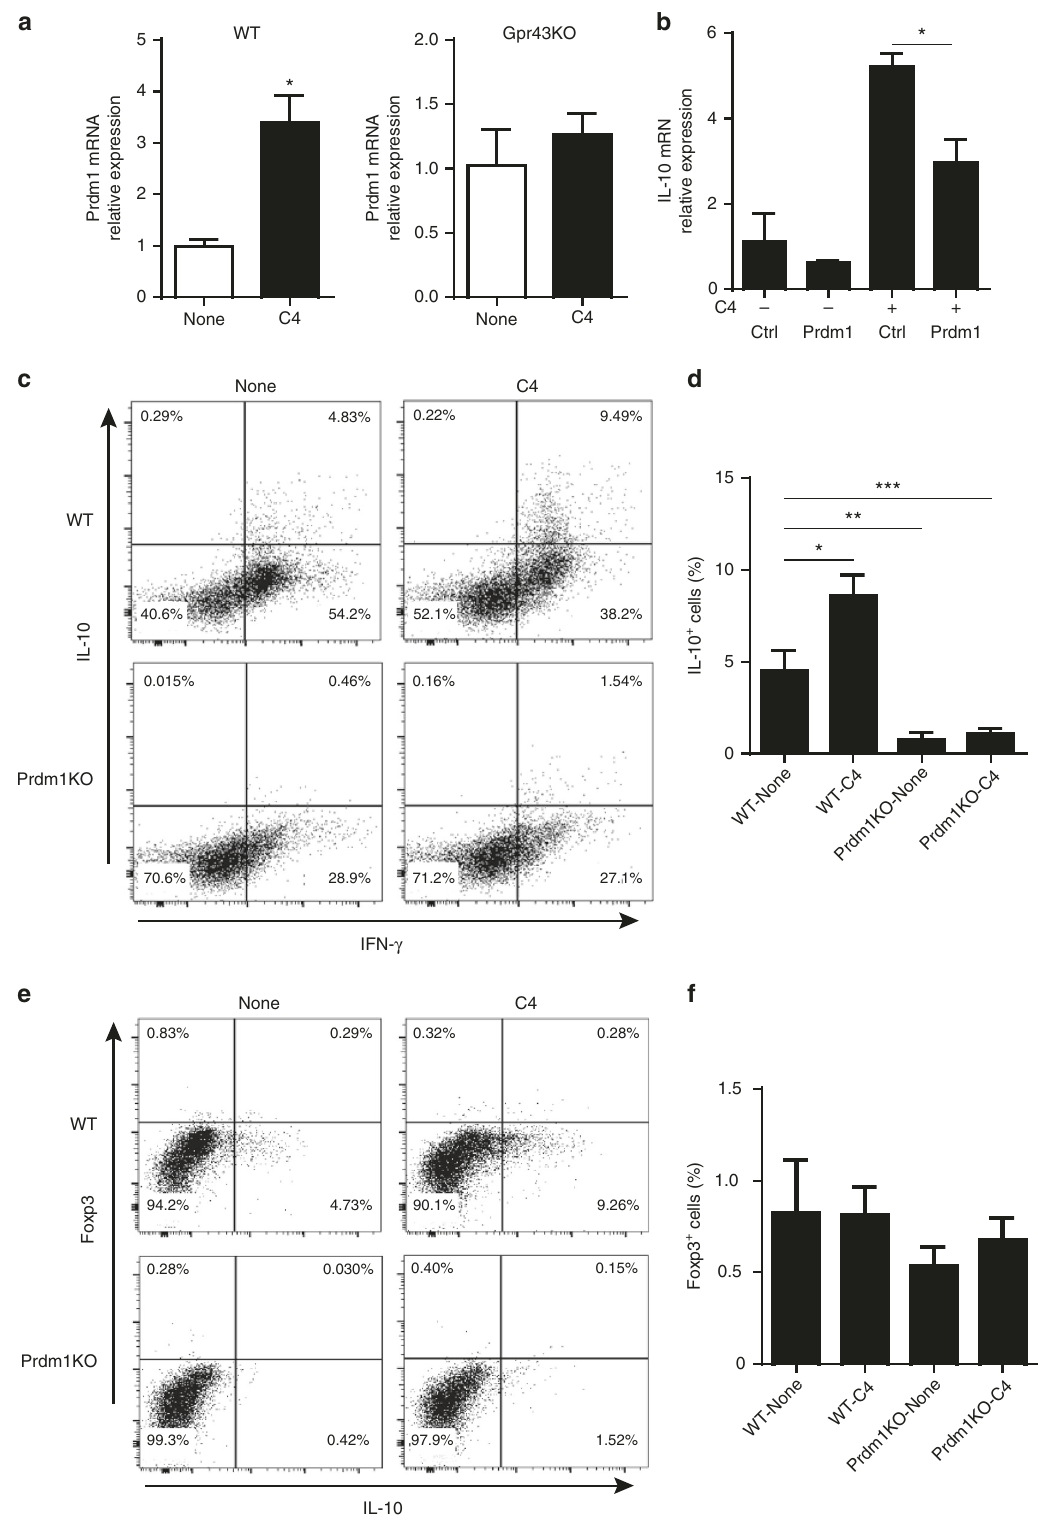
Fig. 5 Blimp-1 mediates butyrate induction of IL-10 production in Th1 cells. a WT CBir1 (WT) and Gpr43 − / – CBir1 Tg (Gpr43KO) Th1 cells ( n = 3/group) were cultured with APC and CBir1 peptide in the presence or absence of C4 for 5 days. The expression of Blimp-1 was examined by qRT-PCR. b WT CBir1 Th1 cells were transfected with Prdm1 siRNA or control siRNA. After 24 h of transfection, the cells were treated with or without C4, and IL-10 expression was determined by qPCR. c – f WT and Prdm1 − / − Th1 cells were cultured with APC and anti-CD3 mAb in the presence or absence of C4. Expression of IL-10, IFN- γ , and Foxp3 was determined by fl ow cytometry. qRT-PCR results are shown as mean ± SD of triplicates, and FACS pro fi les are a representative of triplicates from one of three experiments performed. * p < 0.05, ** p < 0.01, *** p < 0.001 one-way ANOVA